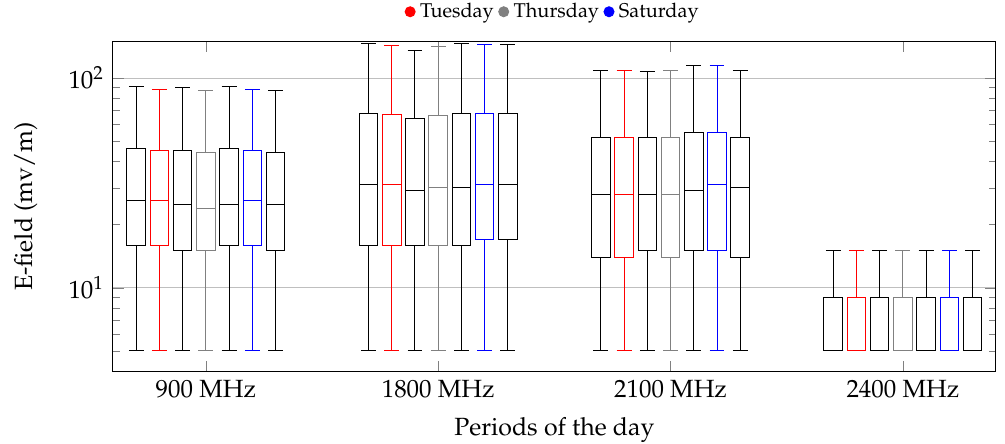
Figure 12. Distribution of the E-field for different frequency bands and days of the week. The results are grouped for the frequency band, and the days of the week are highlighted in each